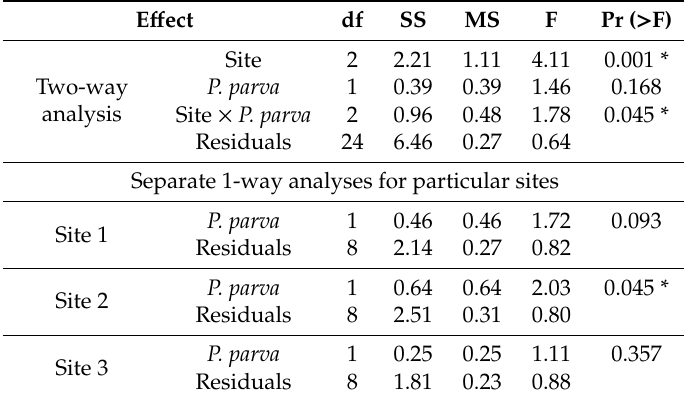
Table 4. PERMANOVA results of the impact of site and the presence of Pseudorasbora parva on the taxonomic composition of the studied fish community. Df—number of degrees of freedom, SS—sum of squares, MS—mean square, F—test statistic, Pr ( > F)— p -value (statistical significance).